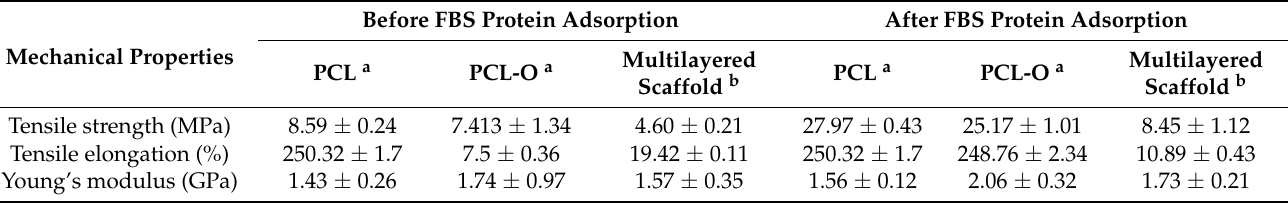
Table 6. Tensile properties of pristine polymers and multilayered scaffold before and after protein